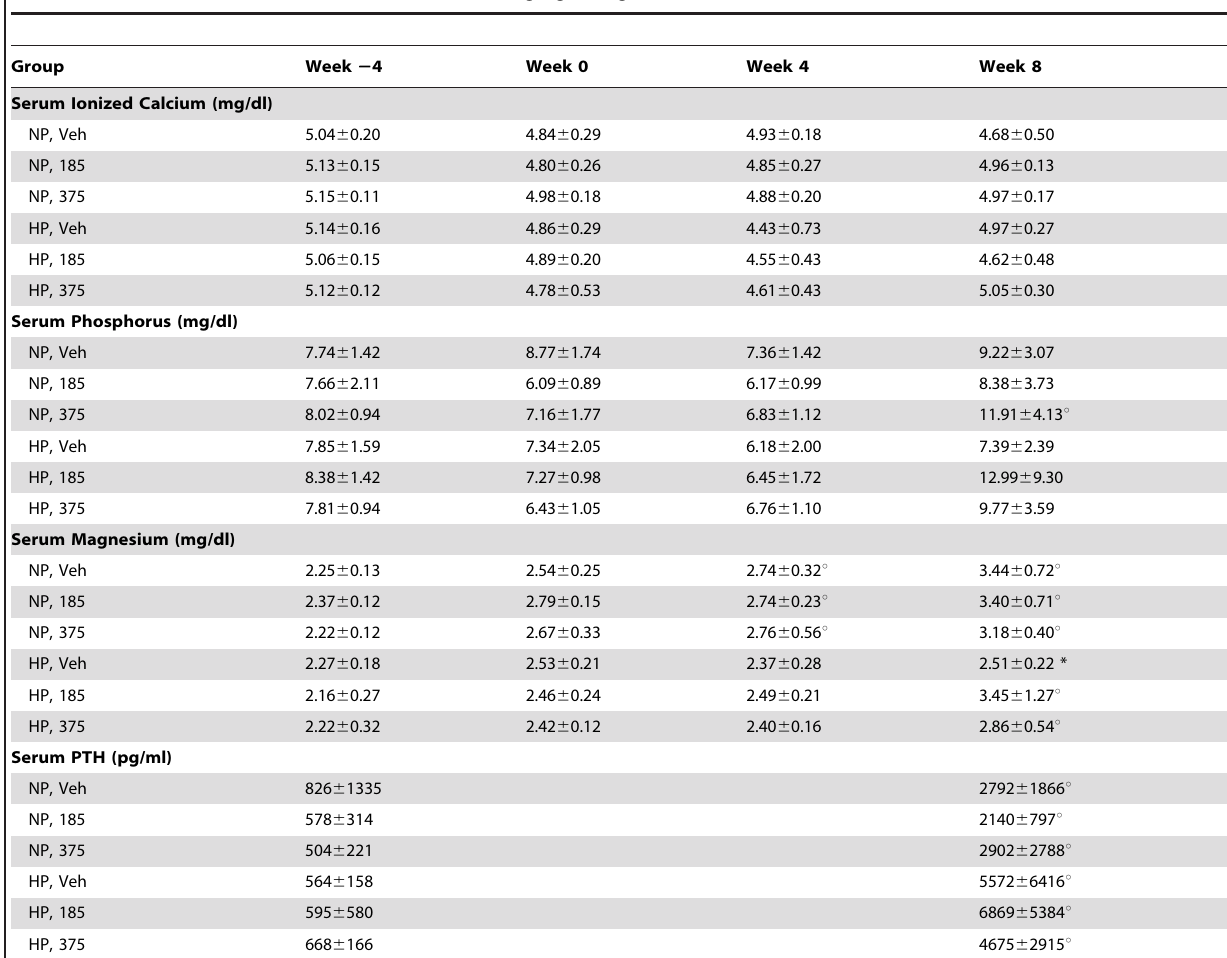
Table 2. Serum biochemistry over time of 5/6 th nephrectomized rats receiving normal phosphorus (NP) or high phosphorus (HP) diet, in combination with vehicle (Veh), 185 or 375 mg/kg